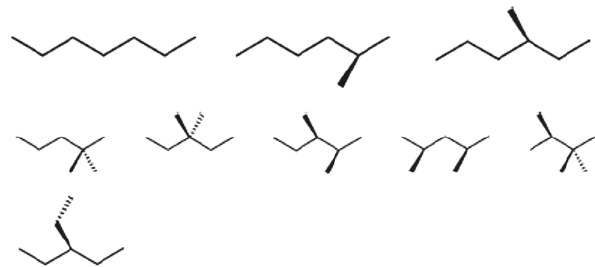
Figure 2: Heptane isomers Top: most reactive, Middle: least reactive, and Bottom: intermediate reactivity. Picture is adopted from [24].